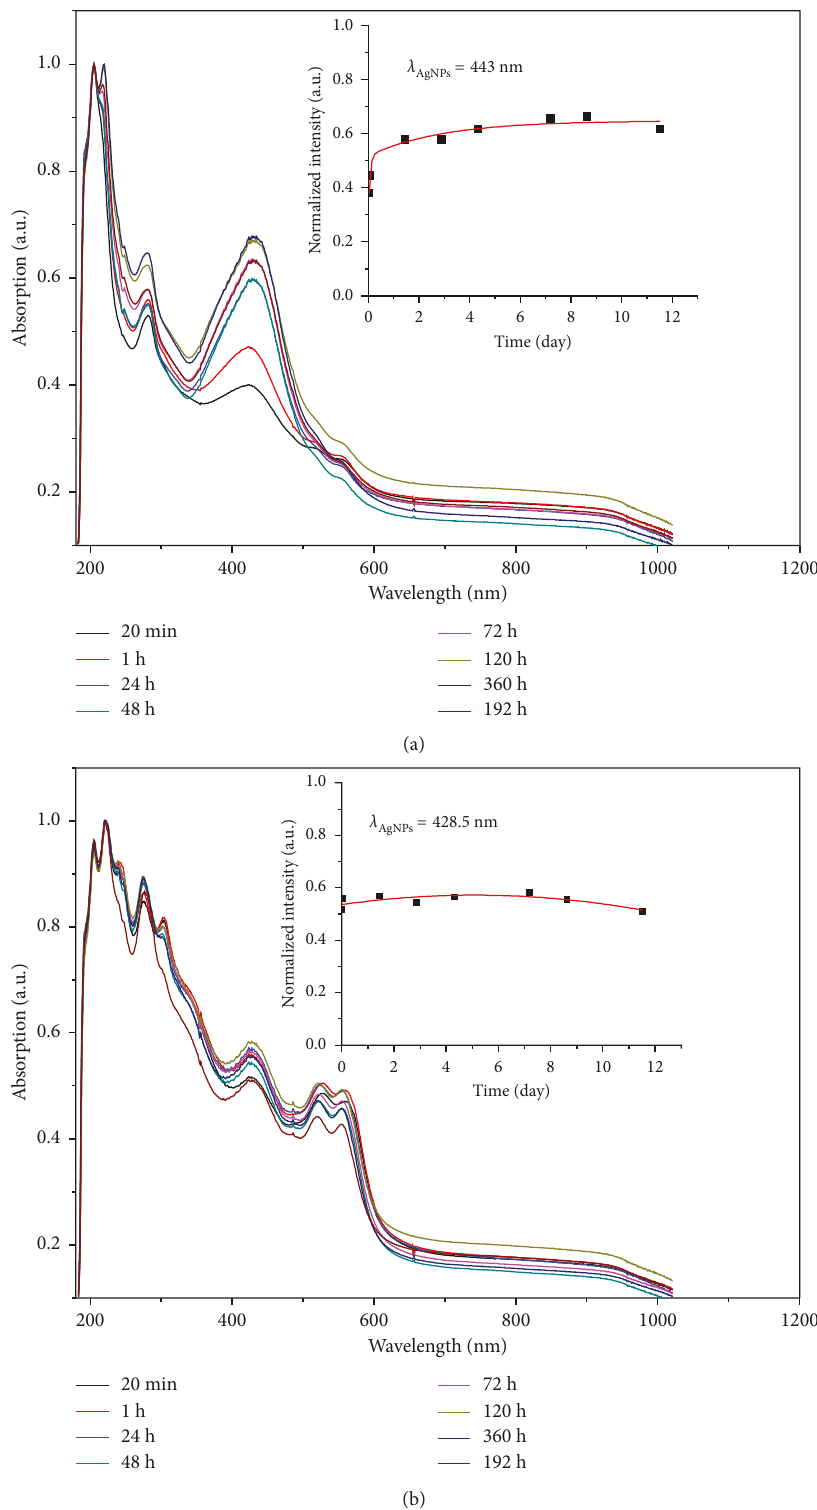
Figure 2: UV–Vis spectra collected over time during the formation of AgNPs in (a) 0.1 ml and (b) 0.4 ml of cochineal pigment solution. Insets follow the intensity of the absorbance peak over time (0.1 ml of cochineal extract: 443 nm and 0.4 ml cochineal extract: 428.5